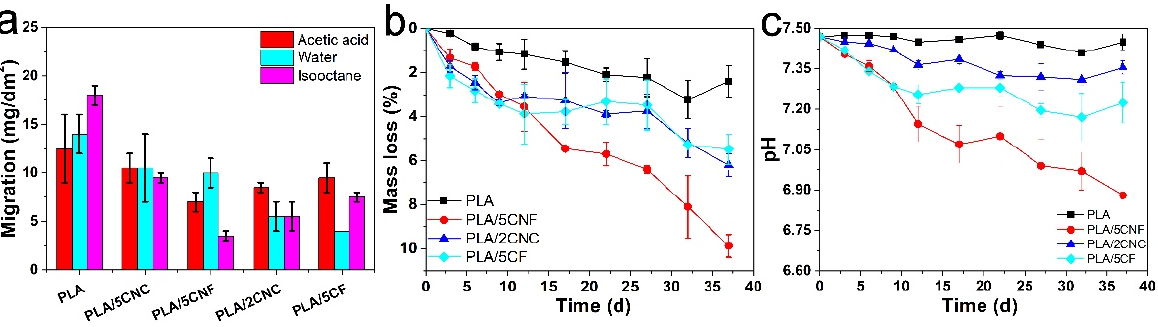
Figure 7. Overall migration levels ( a ), mass loss ( b ), and the change of pH ( c ) of PLA film and composite films.